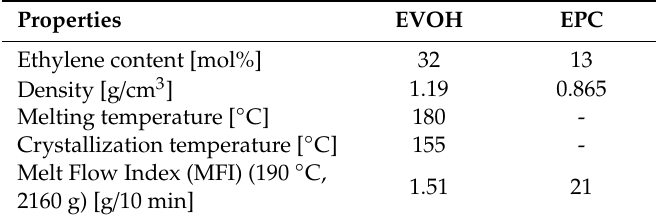
Table 1. Properties of ethylene–vinyl alcohol copolymers (EVOH) and ethylene-propylene copolymers